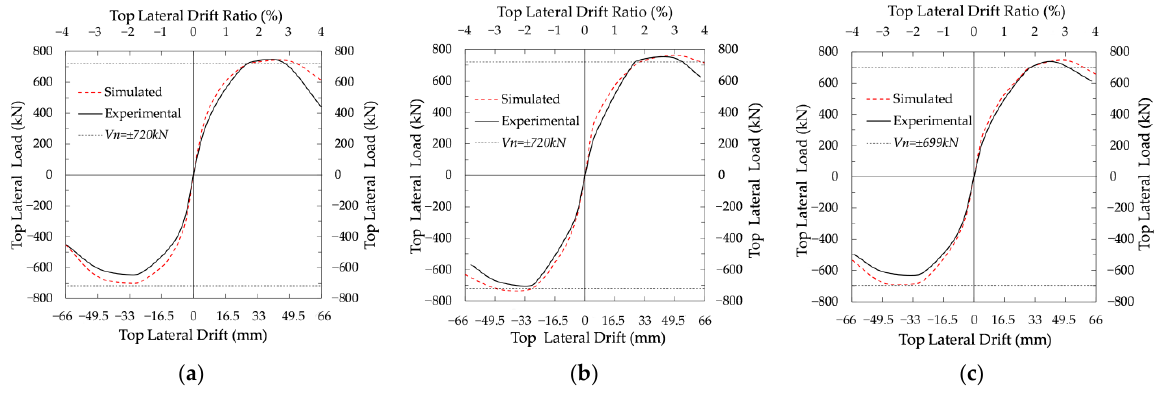
Figure 27. Comparison of skeleton curves of three numerical models. ( a ) CS-1; ( b ) CS-2; ( c ) CS-3.